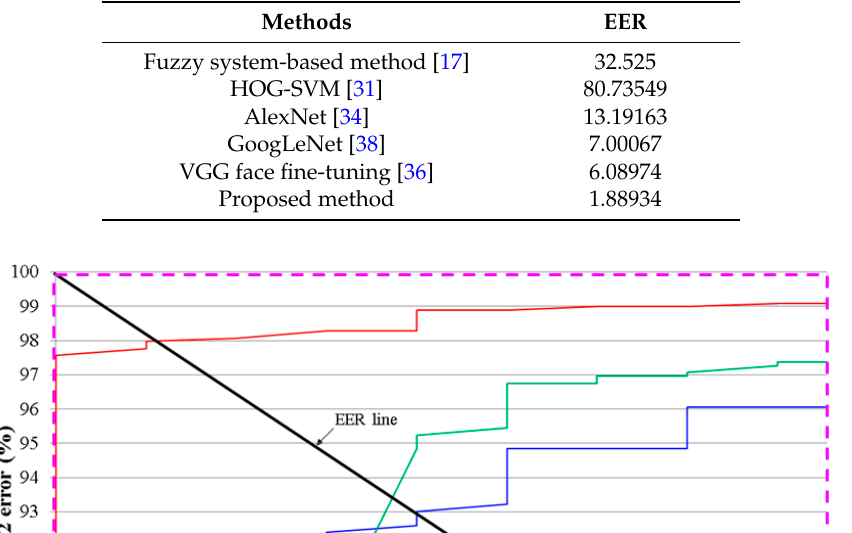
Table 9. Comparative errors for our method and the other methods with open database of NIR eye images [18] (unit: %).